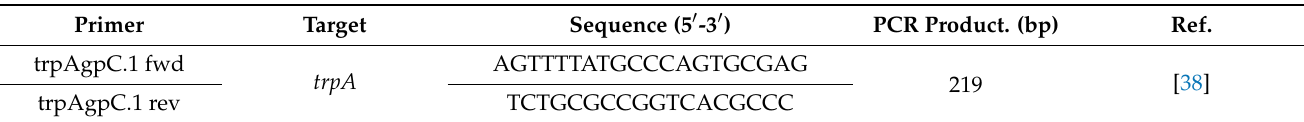
Table 9. List of primers used for the distinction of phylogroups A or C.